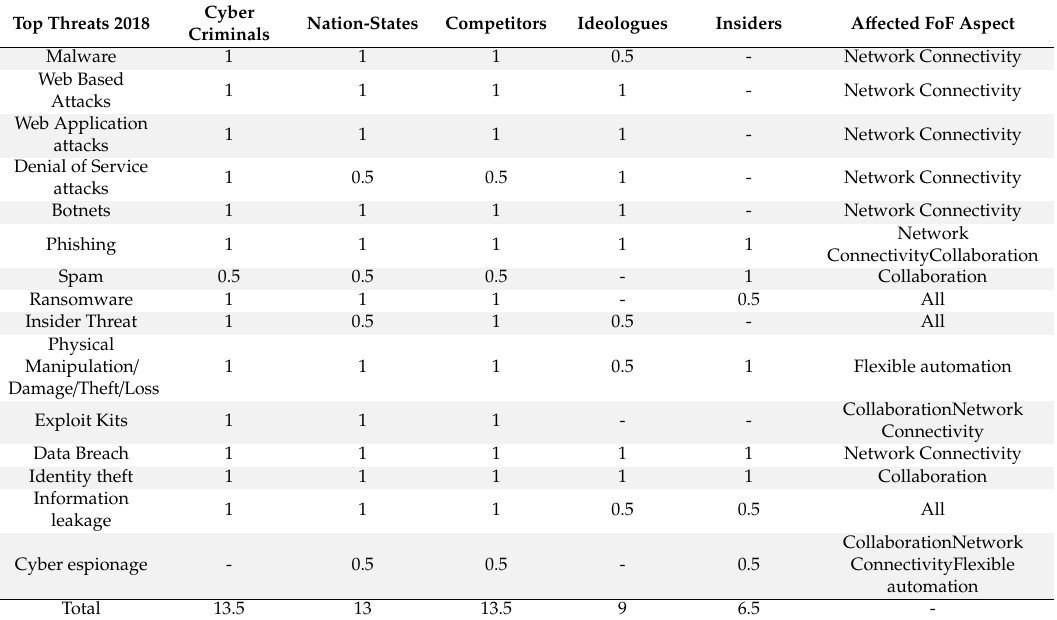
Table 2. Mapping 2018 observed threats [5] to